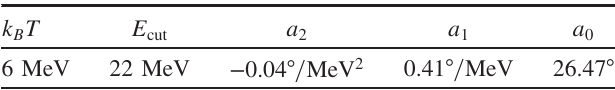
TABLE I. Parameters that were used to generate a TNSA beam in the simulation